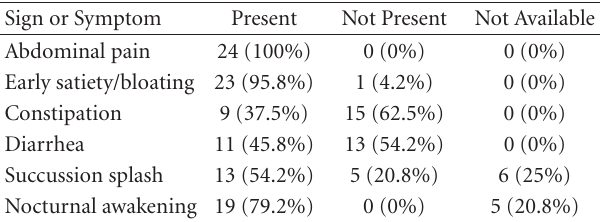
Table 1: Summary of signs and symptoms of the subjects ( n = 24).